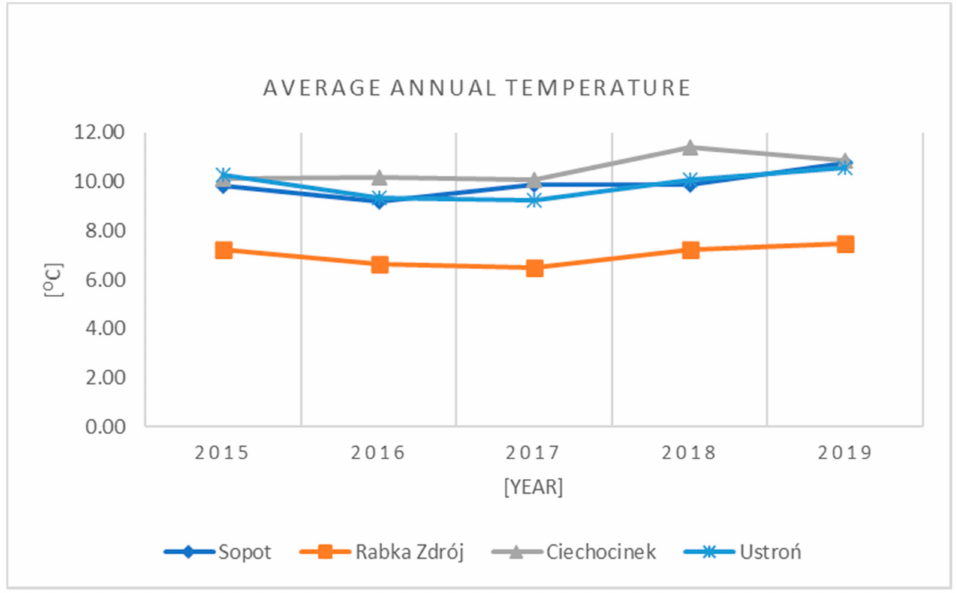
Figure 2. Average annual air temperature statistics for health resorts in 2015–2019. The highest average wind speed(Figure 3) of the five years analyzed occurs in the health resorts of Ustro´n and is 10.84 km/h, then in Sopot where the average wind speed in the health resorts during the period considered was 9.92 km/h consecutively, in Ciechocinek, 8.67 km/h and Rabka Zdr ó j, 5.54 km/h. Wind speed has a stimulating effect on mixing processes, and in addition, in the case of large urban agglomerations, which are a cluster of age emitters, it has an impact on the displacement of pollutants outside the city. Therefore, there is usually a decrease in the height of concentrations of pollutants with an increase in wind speed